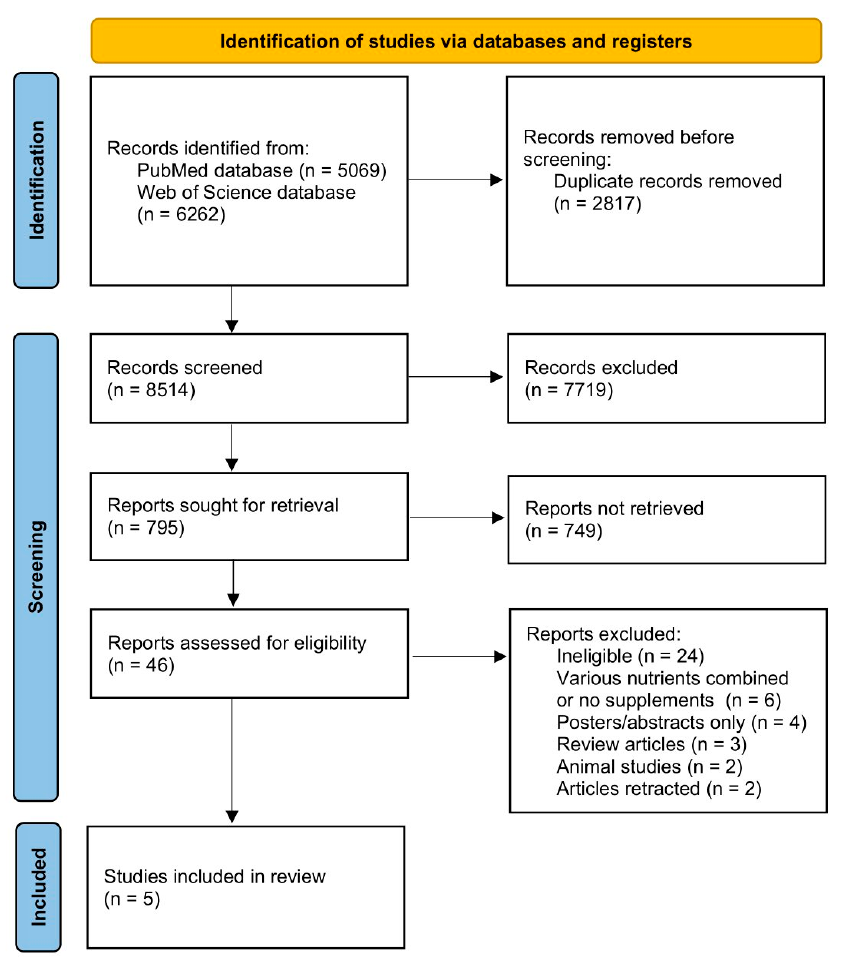
Figure 1. The procedure of identifying, selecting, assessing eligibility, and including studies.